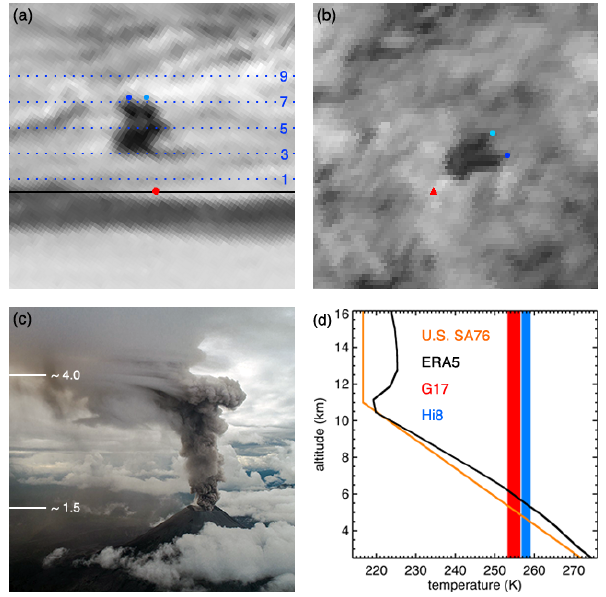
Figure 9. The 14 August 2019 eruption of Karymsky: (a) GOES- 17 band 2 fixed grid image (8 × magnification) at 04:30UTC, (b) Himawari-8 band 3 CEReS V20190123 image at 04:30UTC, and (c) quadcopter image at 04:45UTC. The red diamond/triangle marks the volcano base, while the light and dark blue dots indi- cate two identifiable plume top elements in the satellite images. In panel (a) , the baseline (solid black) and the odd number isoheights (in km, dotted blue) are also drawn. In panel (c) , the white markings indicate height in kilometers. Panel (d) shows the ERA5 tempera- ture profile (black line), the U.S. Standard Atmosphere 1976 tem- perature profile (orange line), and the range of the GOES-17 and Himawari-8 minimum BT 11 between 04:30–05:30UTC (red and blue shaded